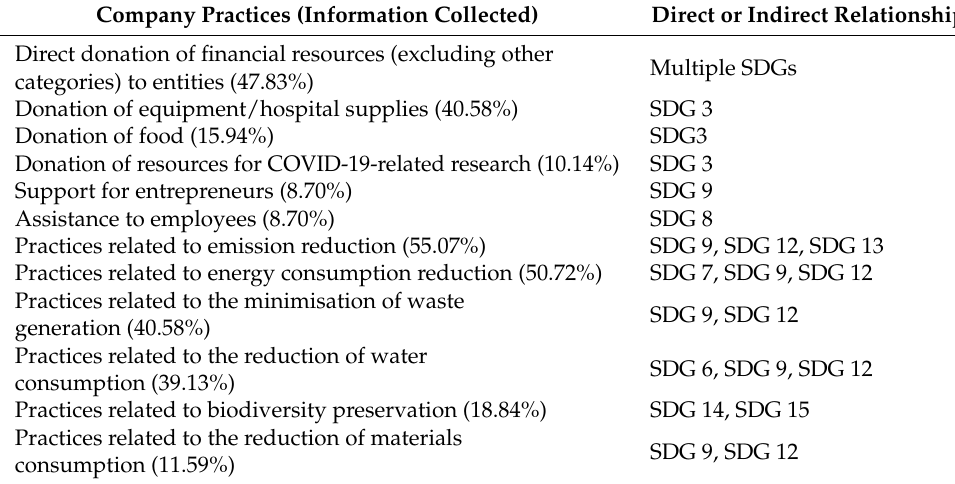
Table 2. Relationship between company practices and SDGs (Source: research